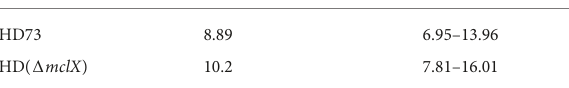
TABLE 1 Insecticidal activities of B. thuringiensis strains against Plutella xylostella. Strain